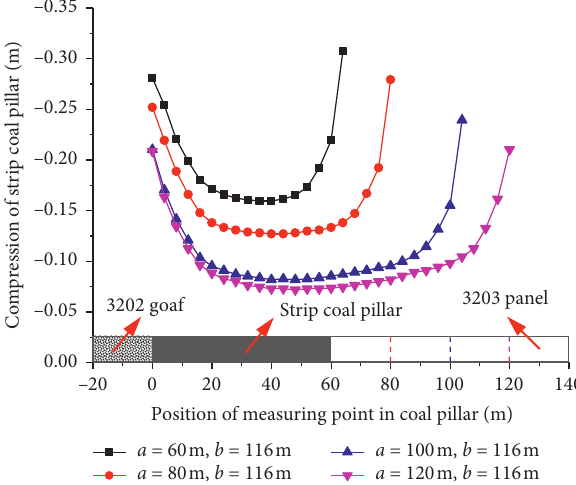
Figure 5: Compression of strip coal pillar under different mining widths.